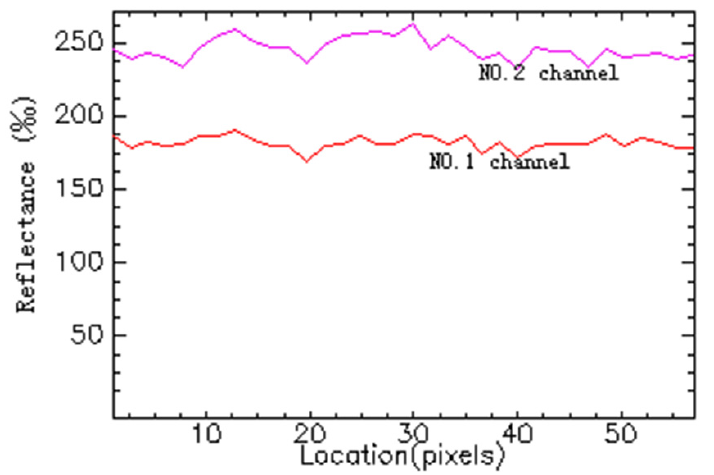
Figure 9. The bare land reflectance of channels 1 and 2 on the cutting line of an AVHRR/2 image (the location is indicated with the pixel numbers on the line.)